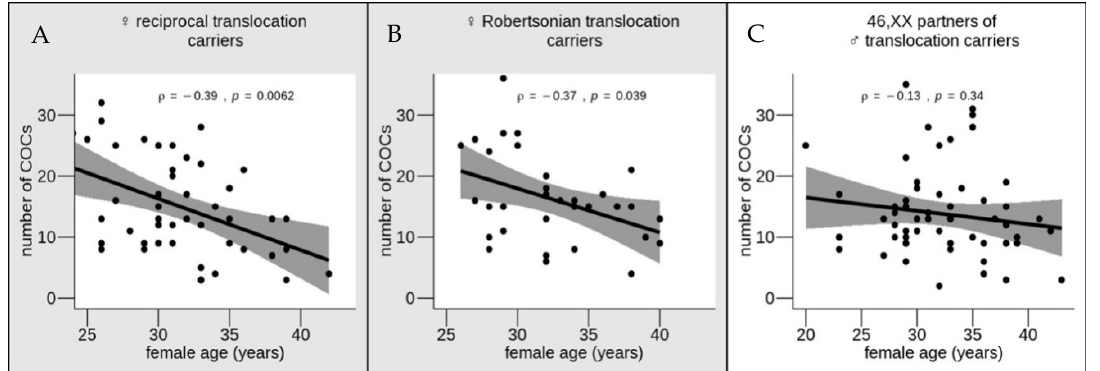
Figure 2. Correlations between the number of cumulus–oocyte complexes (COCs) retrieved after controlled ovarian hyperstimulation and woman’s age in the groups of female reciprocal ( A ) and Robertsonian ( B ) translocation carriers and karyotypically normal partners of male translocation carriers ( C ); Table A1. The statistically significant correlations are shaded in gray ( p < 0.05, Spearman